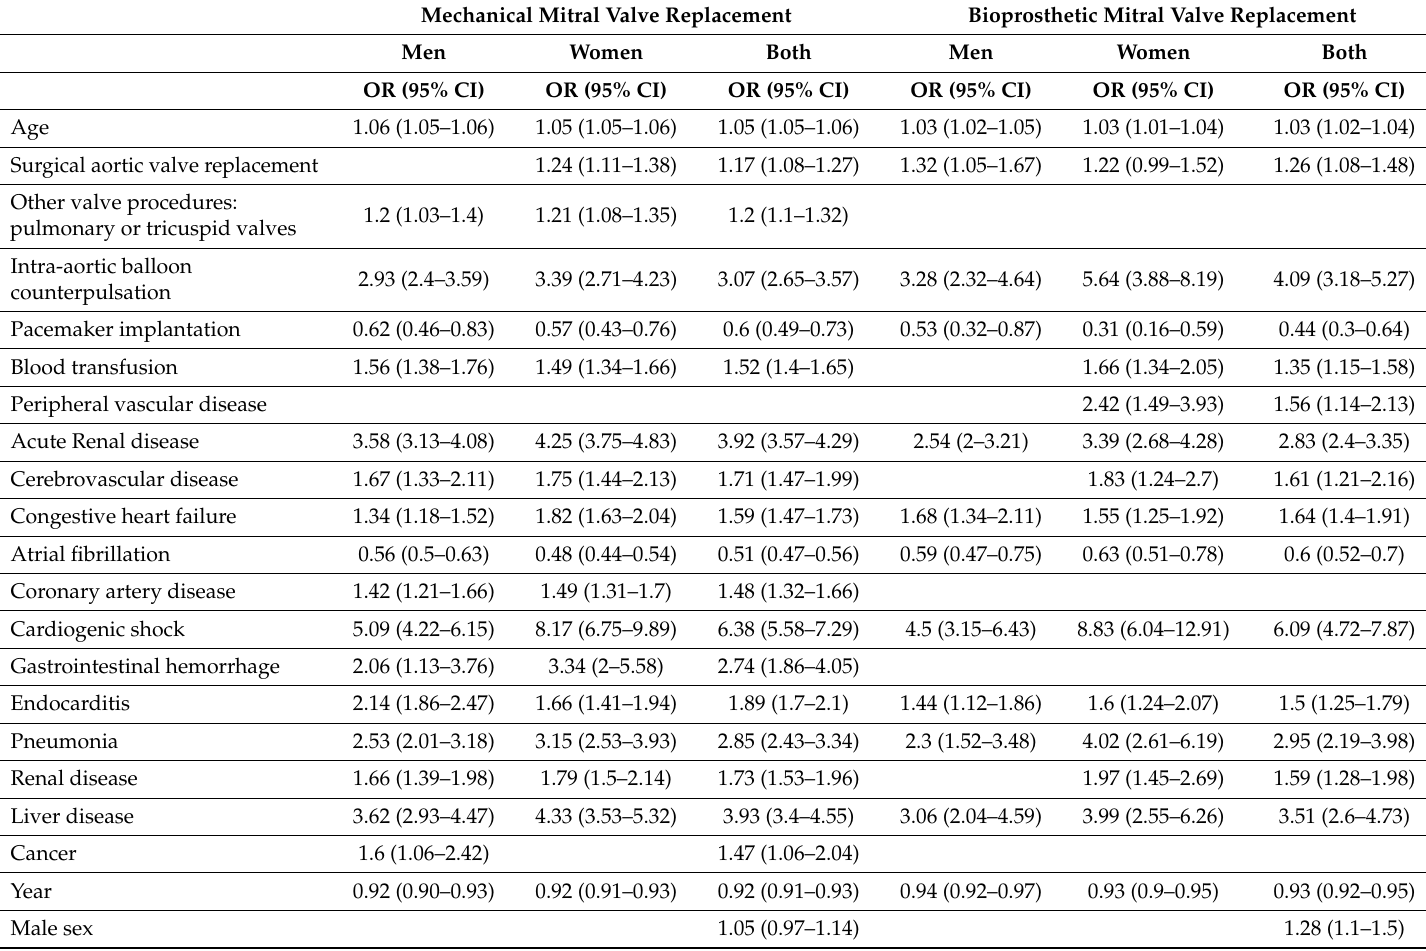
Table 4. Multivariable analysis of factors associated with in-hospital mortality among women and men undergoing mitral valve replacement according to the type of